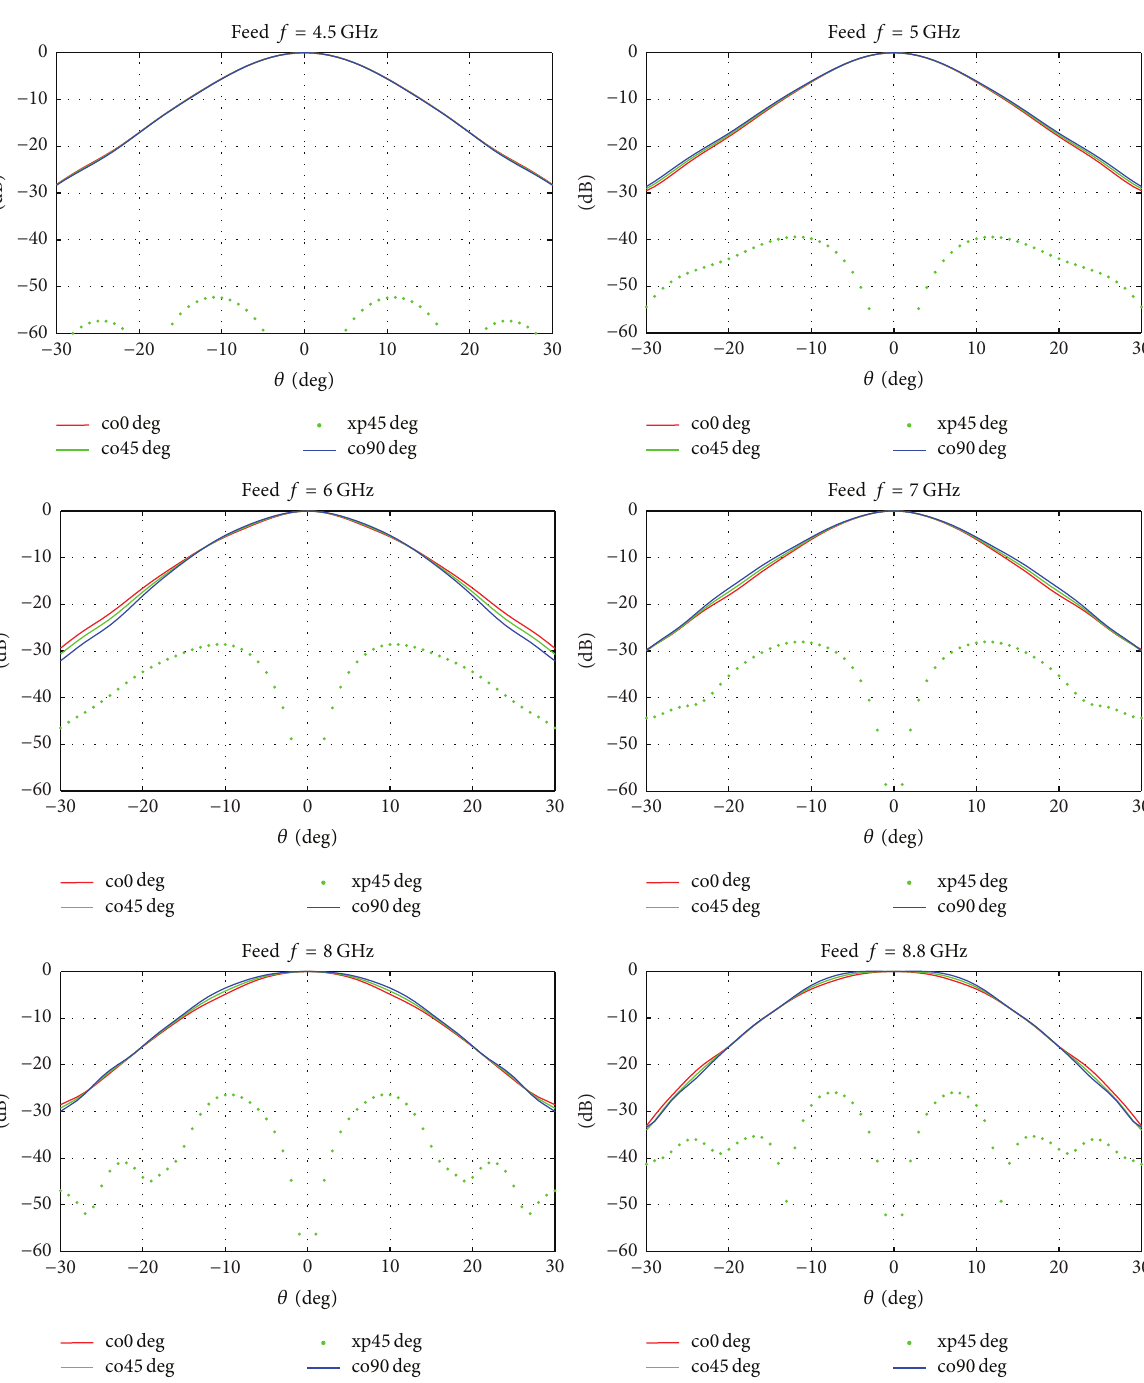
Figure 7: Simulated beam pattern of feed (blue-copolar 𝐻 -plane, red-copolar 𝐸 -plane, green-copolar diagonal plane, and green dot-cross- polar diagonal